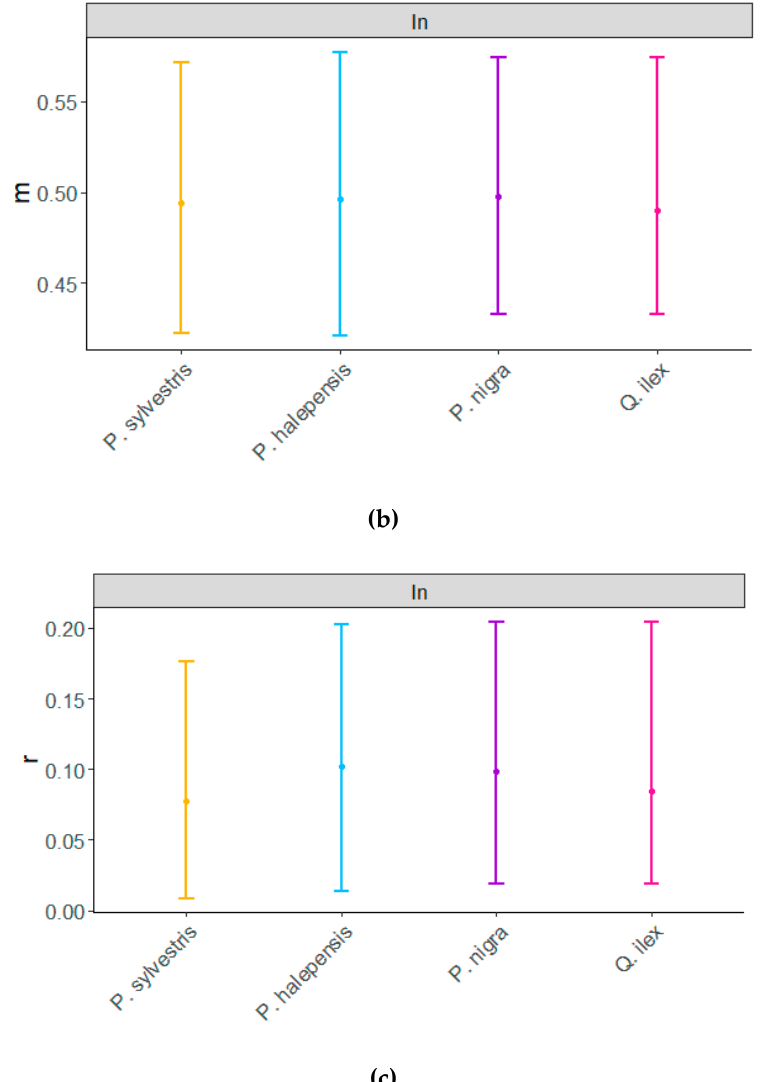
Figure A1. Bars with the 95% level of the central values for each coefficient in Equation (1) (panels ( a – c ) correspond, respectively, to coefficient η , m and r ) and each species calculated at the individual (In)